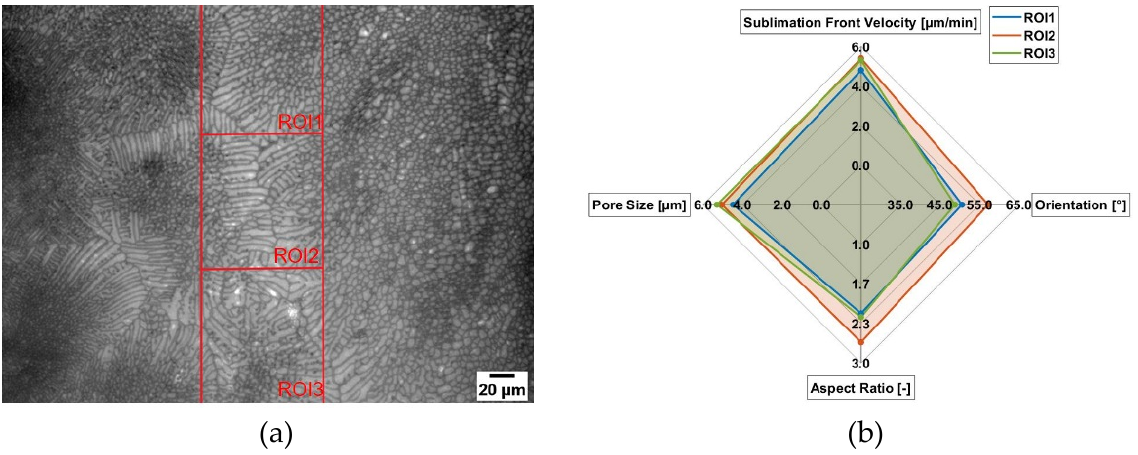
Figure 10. Influence of the microstructure on the local sublimation front velocity for maltodextrin (c = 0.15 w/w, 1 K/min cooling rate). ( a ) Lyomicroscope Image and ( b ) Results